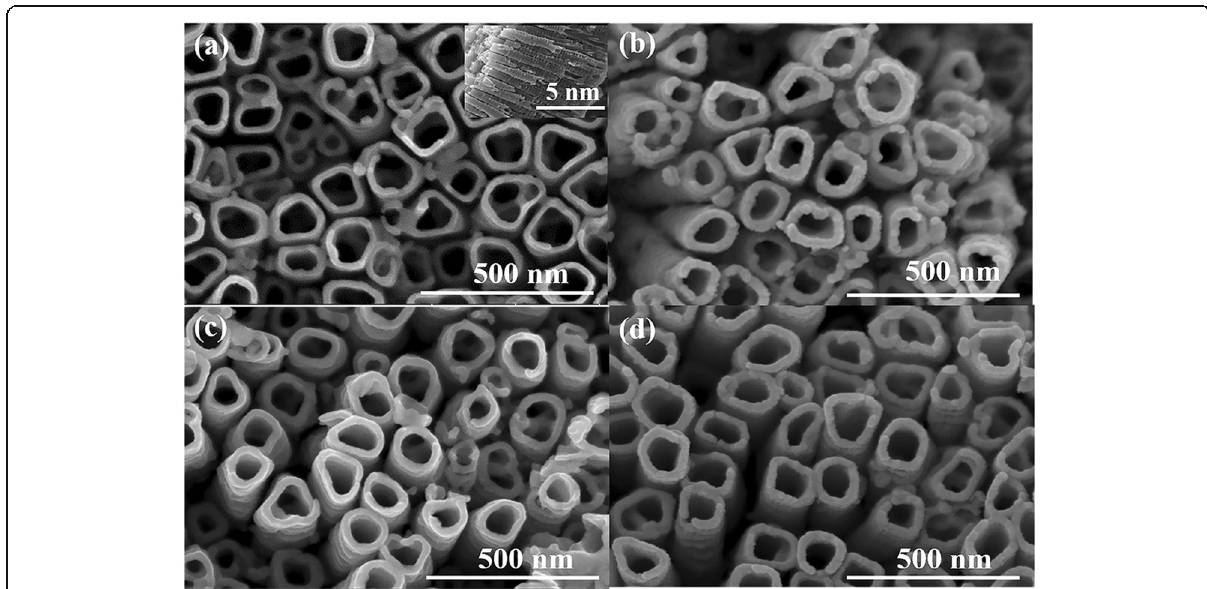
Fig. 1 SEM images of TNTAs/QDs with various ALD cycles overlayer: a 0 cycles, b 30 cycles Al 2 O 3 , c 10 cycles ZnO, and d 25 cycles TiO 2 . The inset in a is a cross-sectional view of the well-aligned quantum dot-sensitized TiO 2 nanotube arrays without any overlayer